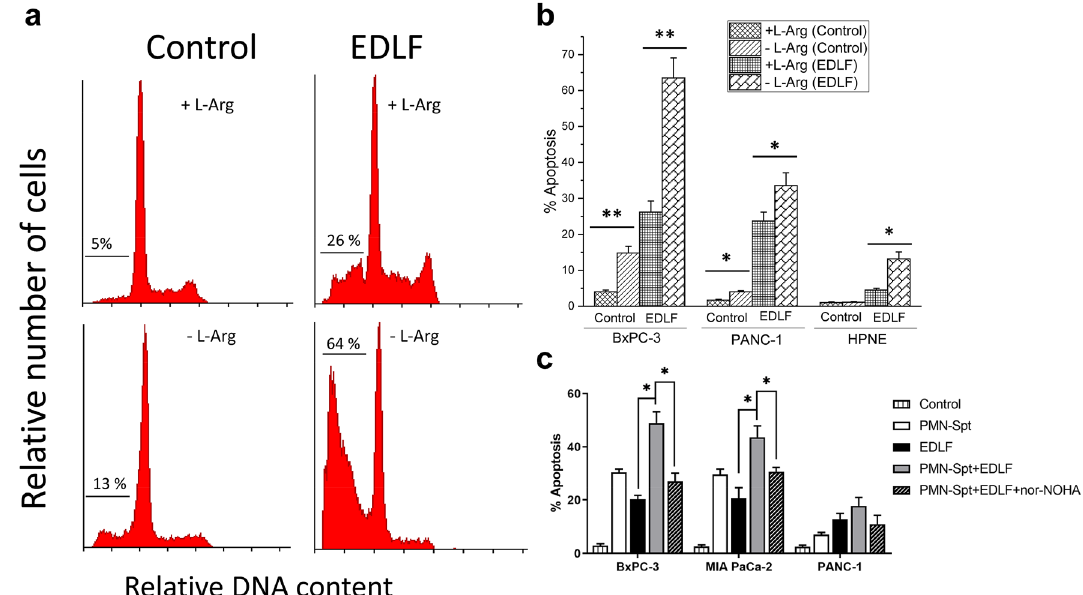
Figure 7. Arg deprivation potentiates the apoptotic action of ER-targeted edelfosine in human pancreatic cancer cells. ( a ) BxPC-3 cells, in L-Arg-containing (+ L-Arg) or L-Arg-deficient (− L-Arg) culture medium, were incubated in the absence (Control) or presence of 20 µM edelfosine (EDLF) for 48 h, and then analyzed for cell cycle profiling. Representative histograms, from at least three different experiments, are shown, and the percentages of cells at sub-G 0 /G 1 (apoptosis) are indicated in each cell cycle profile. ( b ) Different human pancreatic cancer cell lines (BxPC-3, PANC-1) and non-tumorigenic human pancreatic HPNE cell line, in L-Arg-containing (+ L-Arg) or L-Arg-deficient (− L-Arg) culture medium, were incubated in the absence (Control) or presence of 20 µM edelfosine (EDLF) for 48 h, and then apoptosis was analyzed by flow cytometry as the percentage of hypodiploid cells (sub-G 0 /G 1 ) following cell cycle analysis. ( c ) 1.5 × 10 7 neutrophils were stimulated with 100 nM fMLP, and the supernatant was co-cultured with the human pancreatic cell lines BxPC-3, MIA PaCa-2 and PANC-1 in L-Arg containing culture medium for 48 h in the absence (PMN-Spt) or presence of 20 µM edelfosine (PMN-Spt + EDLF) or 50 µM nor-NOHA plus 20 µM edelfosine (PMN- Spt + EDLF + nor-NOHA). Untreated cells (Control) and cells treated only with 20 µM edelfosine (EDLF) were run in parallel. After treatment, the percentage of apoptosis was determined by Annexin-V staining by